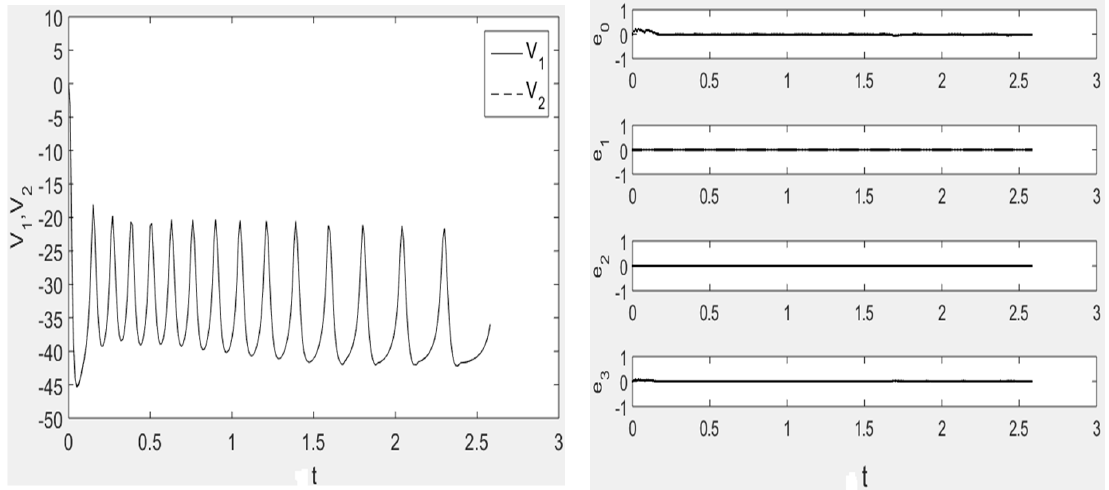
Figure 5. Time history diagram and synchronization discrepancy diagram when H syn = 0.8.